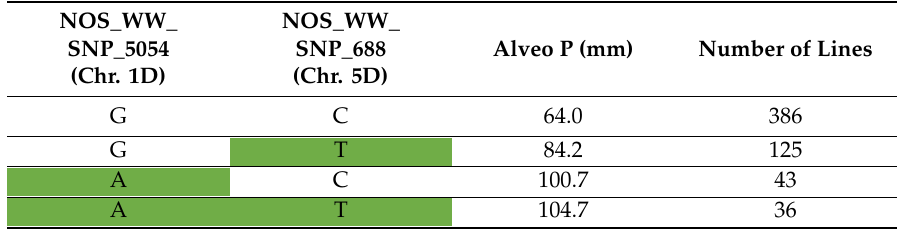
Table 4. Mean values of Alveo P for lines with each combination of alleles of the significant SNPs. Alleles that are positively associated with the trait are marked with green.